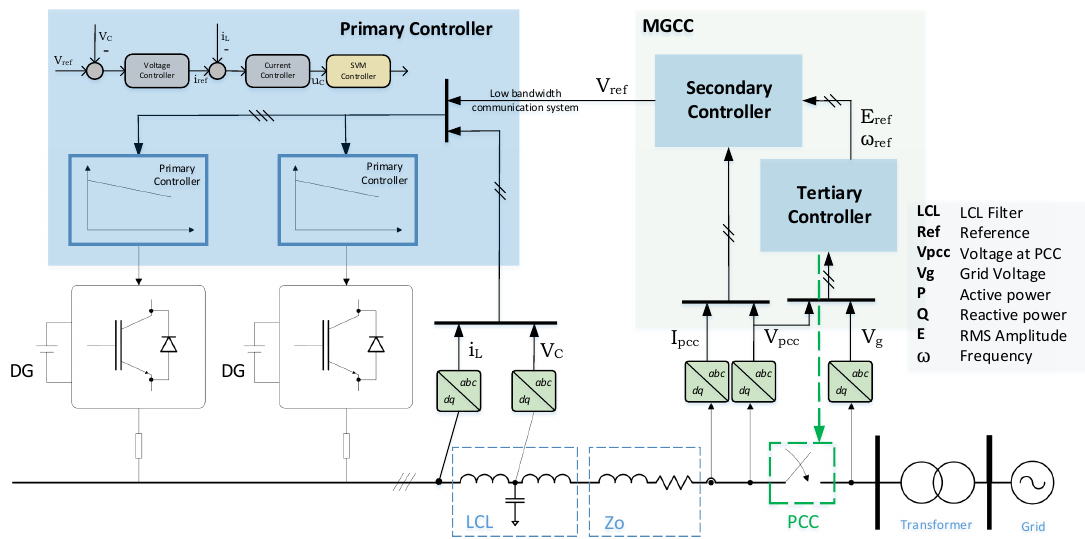
Figure 11. Tertiary controller in SPSS.